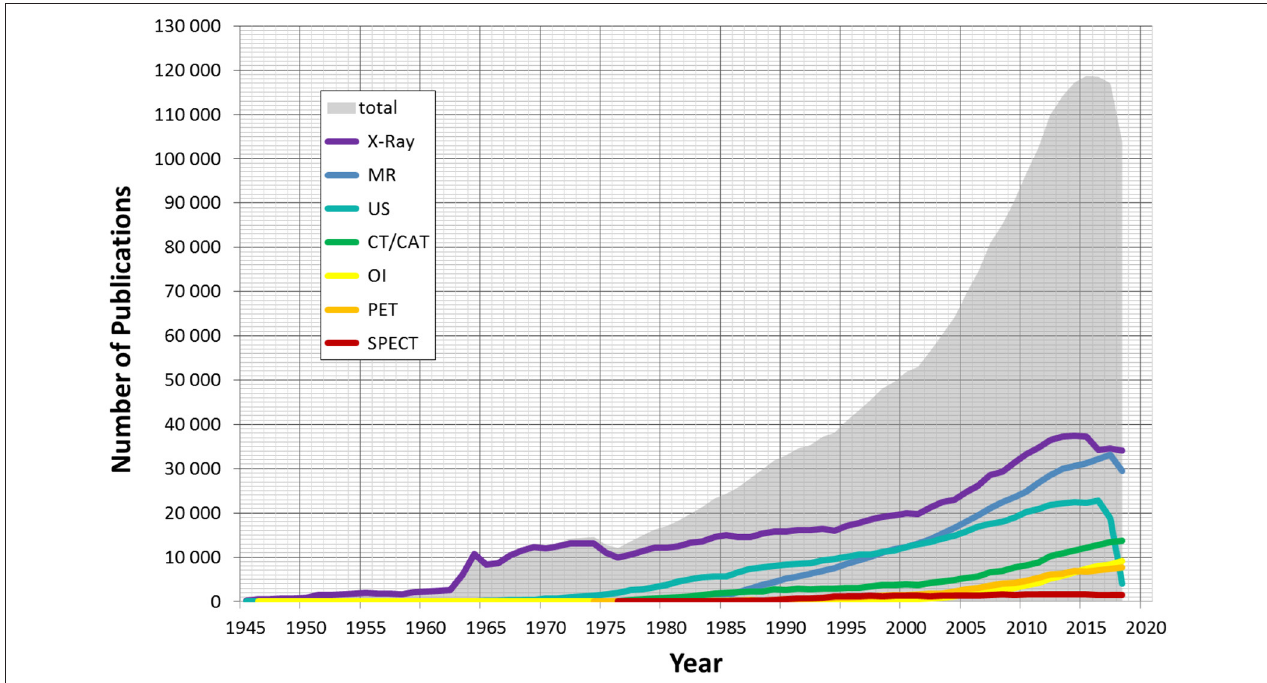
FIGURE 1 | MCDI papers listed in PubMed (gray, shaded area) between 1945 and 2018 (search April 2020: ( m edical) OR ( c linical) OR ( d iagnostic) AND imaging). Note, imaging papers published annually increased by a factor of 1,000 from 1945 to 2018. The colored lines represent papers published on one of the seven most popular imaging methods: X-ray (Purple) and CT (Green) , SPECT (Red) and PET (Orange) , US (Light blue) and MRI (Dark blue) , and OI (Yellow)